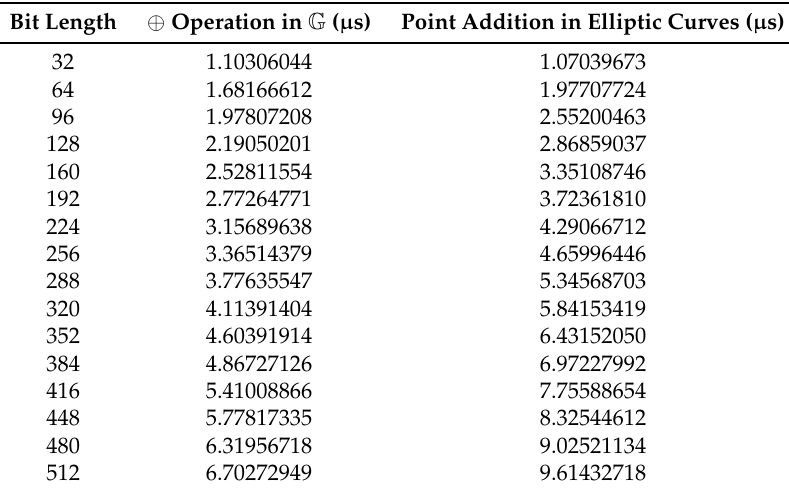
Table 1. Computation time for one single operation in each setting.